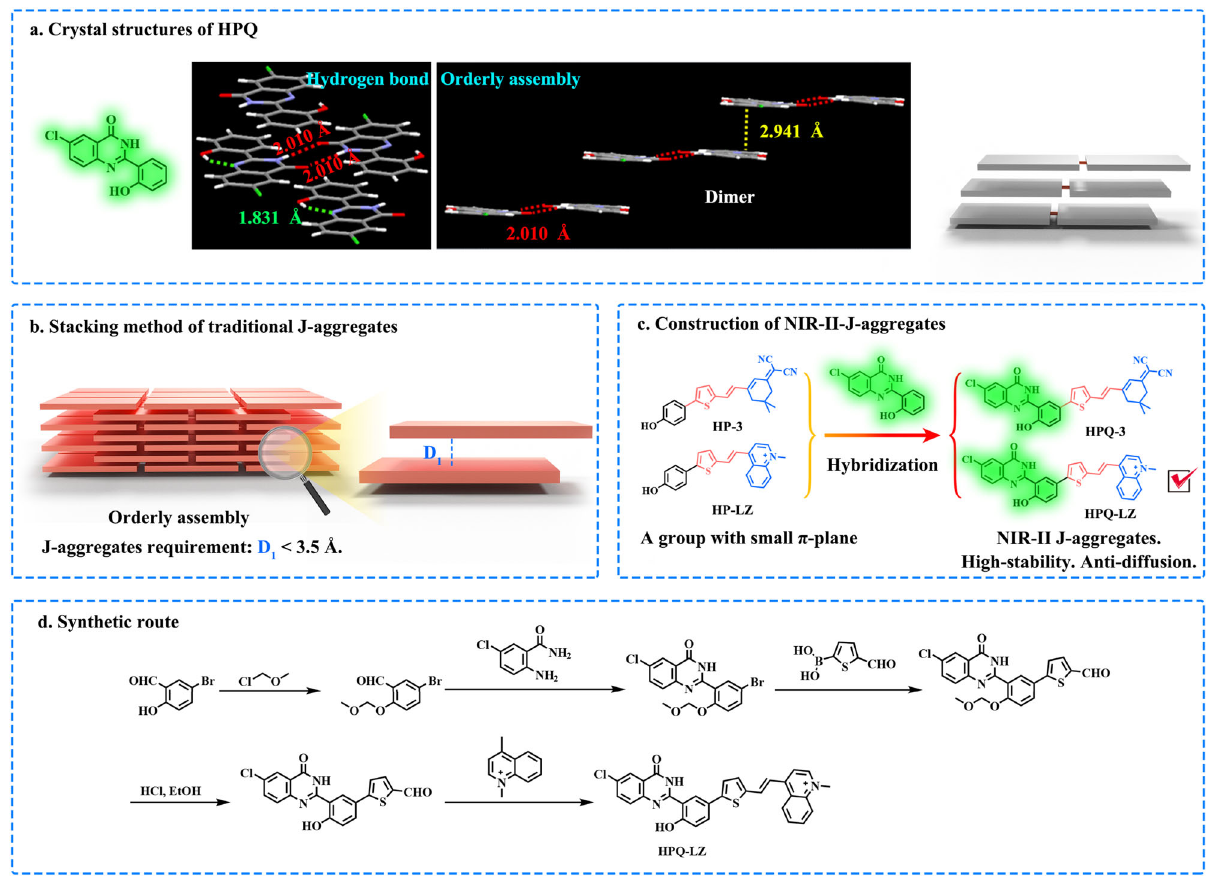
Fig. 2 | Structure of HPQ and traditional J-aggregation strategy. a Crystal structure of HPQ (CCDC: 2045408, the single-crystal data is from our previous article 35 ) and its mechanism of in situ precipitation (strong